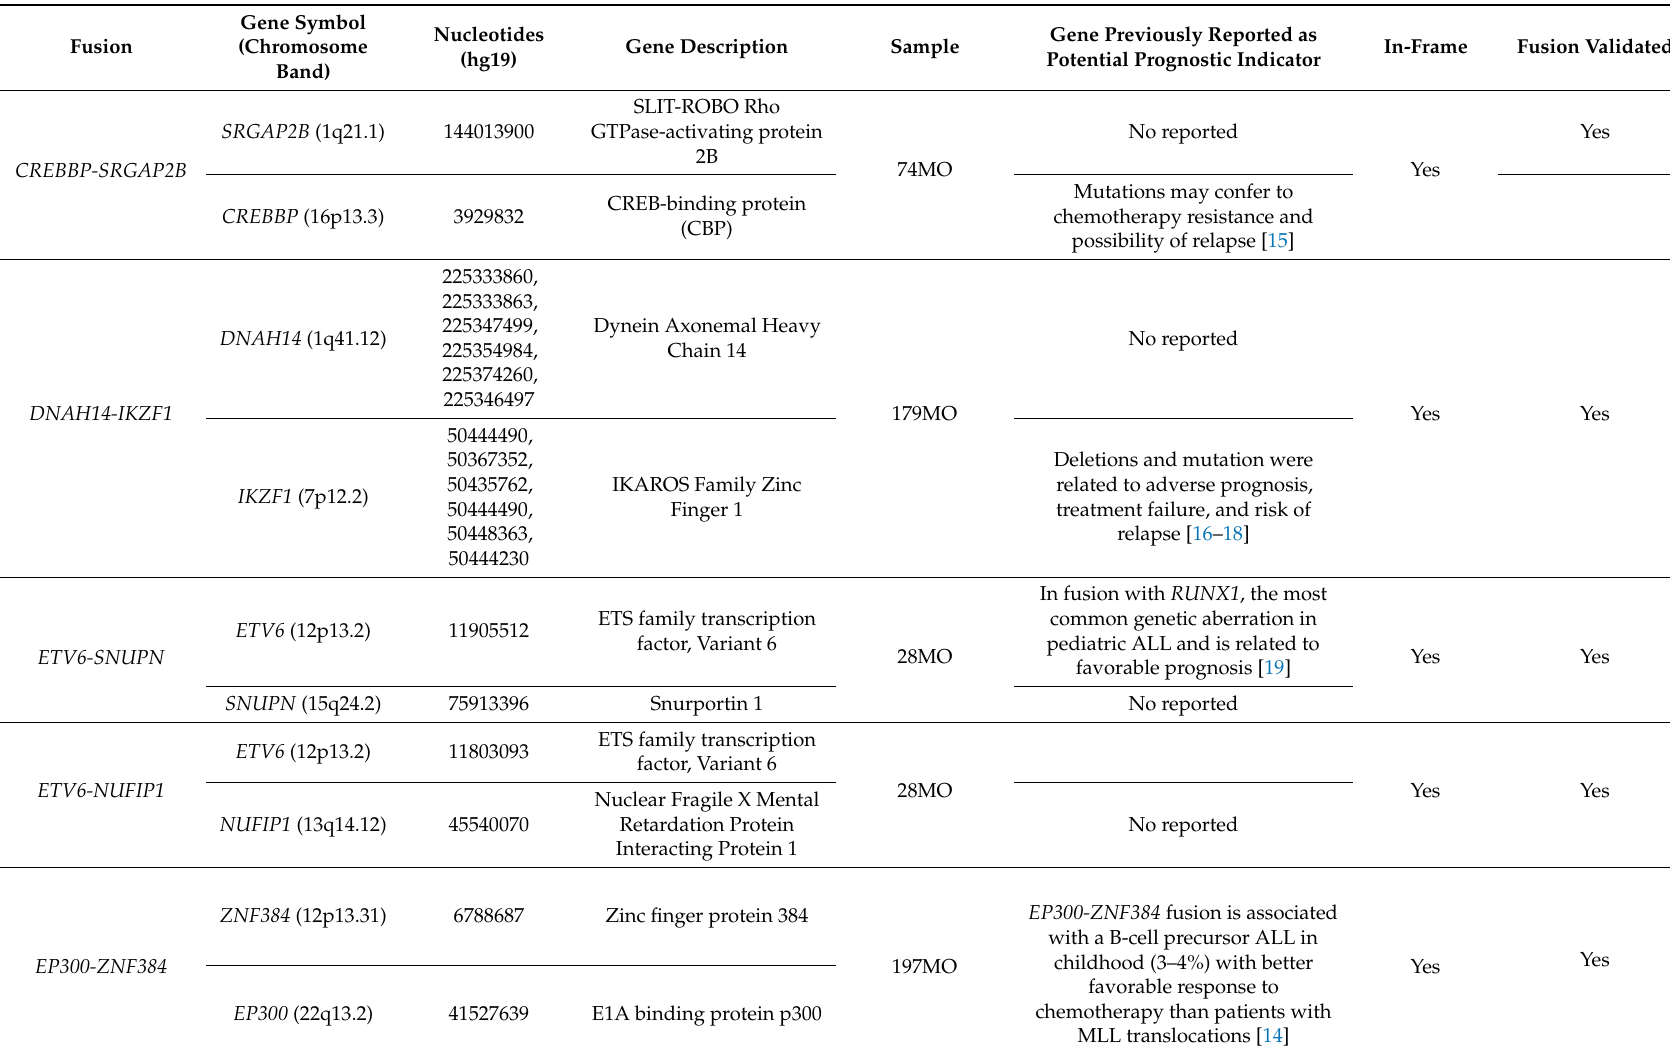
Table 2. In-frame fusion genes found in the acute lymphoblastic leukemia patients by RNA sequencing, genomic localization, and the associated